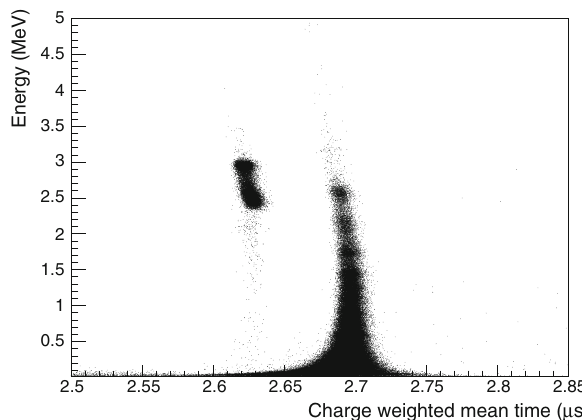
Fig. 22 A scatter plot of energy deposition in Crystal-2 (vertical) versus that deposited in other crystals in the array (horizontal). The 40 K events are identified as the distinct island in the energy spectrum near 3keV in Crystal-2 and 1460keV measured in the one of the other